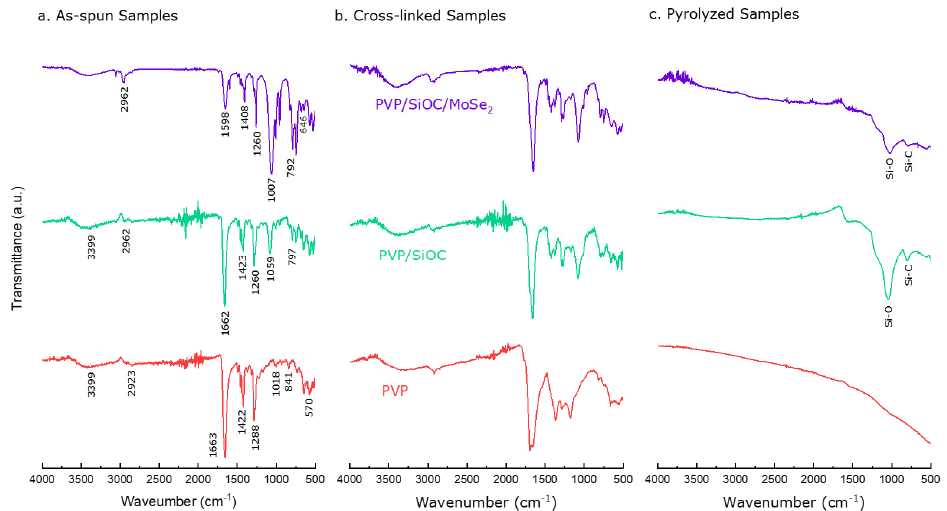
Figure 7. FTIR spectra of ( a ) as-spun, ( b ) cross-linked, and ( c ) pyrolyzed fiber mats. Each figure consists of the FTIR spectra shown for PVP, PVP/SiOC and PVP/SiOC/MoSe 2 fiber mats from bottom to top.